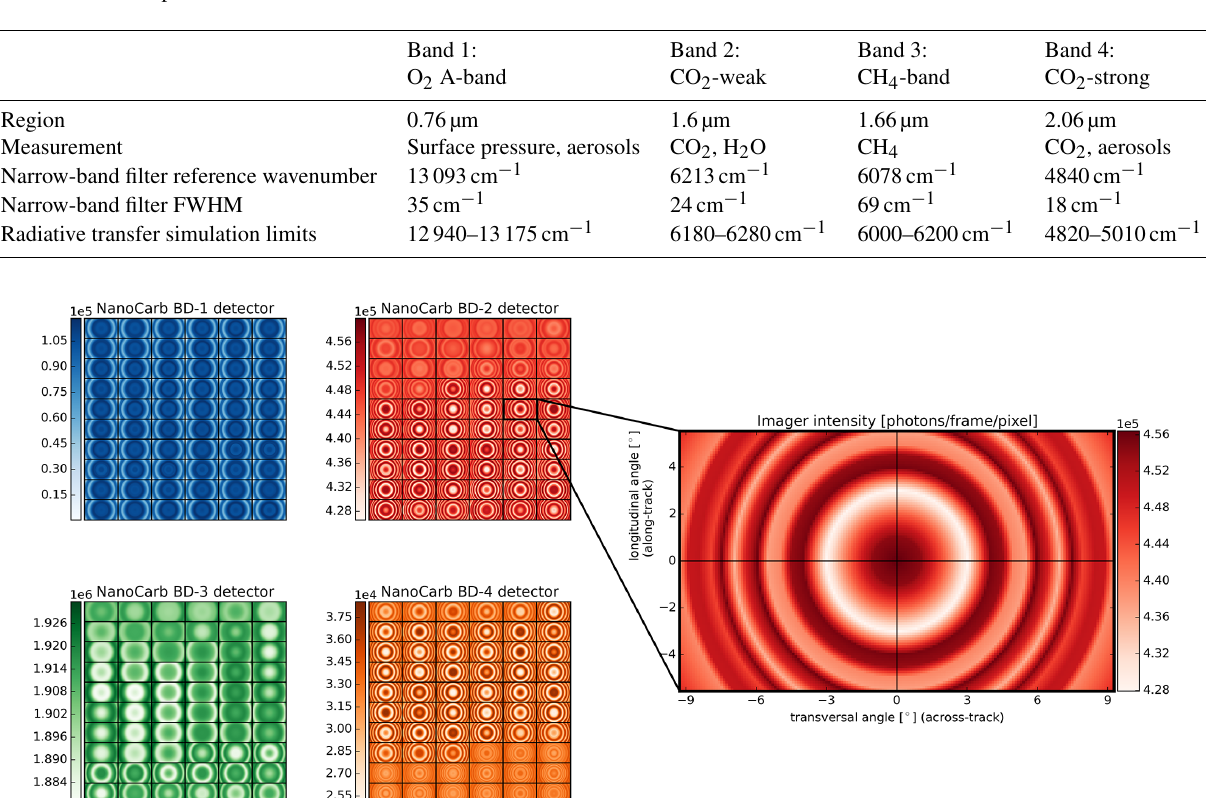
Figure 1. Example of a complete NanoCarb measurement. The left-hand panels show the measured intensities for the four spectral bands (denoted BD in the figure) for all their 60 OPDs and for all FOV pixels. The right-hand panel illustrates the FOV intensity for one given OPD. This example has been computed for a vegetation surface type, with a solar zenith angle of 25 ◦ .